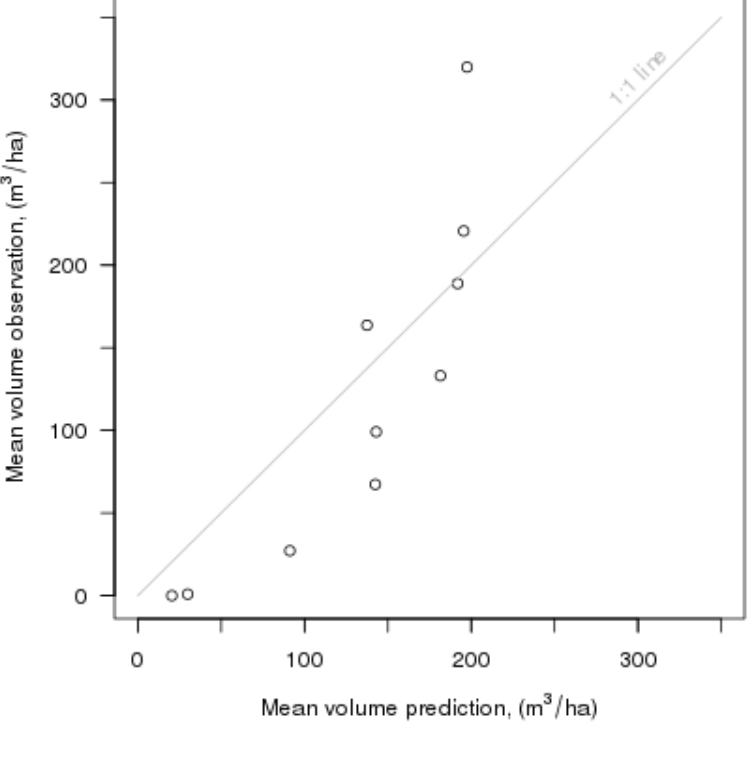
Figure 7. Mean observation versus mean prediction for volume (m 3 ∙ha −1 ). The observations have been sorted and grouped into groups of 20 observations at the minimum based on the observed volume (m 3 ∙ha −1